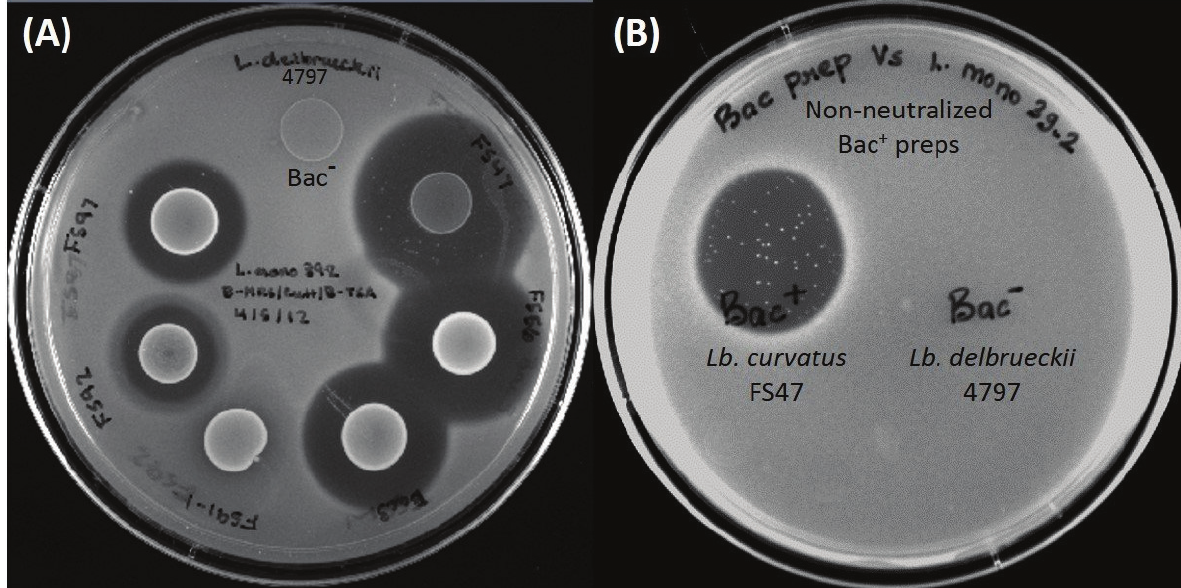
Figure 2. ( A ) Inhibition of L. monocytogenes 39-2 by overlay of prior spotted and incubated culture spots (“deferred antagonism”). Spotted cultures, clockwise from top: Lb. delbrueckii 4797-2 (Bac (cid:2) control), Lb. curvatus FS47, En. faecium FS56-1, Pediococcus acidilactici Bac3, Lactococcus lactis FS91-1, En. thailandicus FS92, En. faecium FS97-2; ( B ) Inhibition of L. monocytogenes indicator lawn spotted with non-neutralized cell free spent broth from Bac + ( Lb. curvatus FS47) and Bac (cid:2) ( Lb. delbrueckii 4797-2) strains (“concurrent